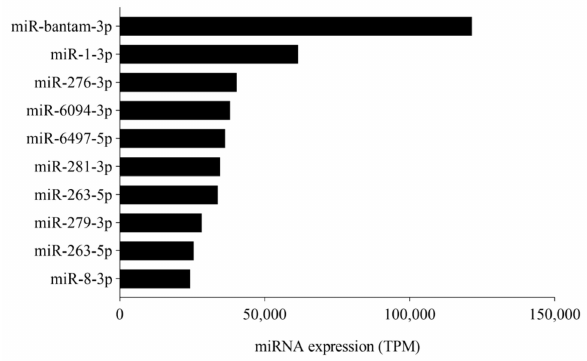
Figure 1. Top 10 abundantly expressed miRNAs in P. xylostella after M. anisopliae infection over the time course. Average expression values of time courses (36 h and 72 h) are presented. TPM denotes transcript per